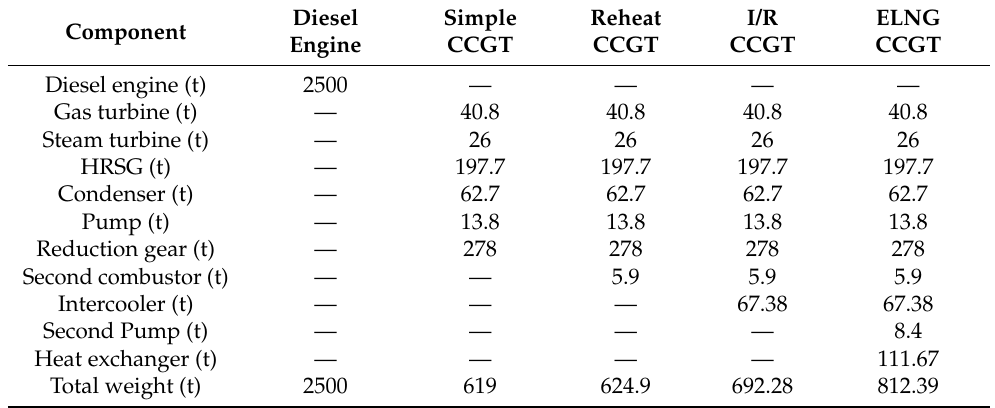
Table 10. Comparison of